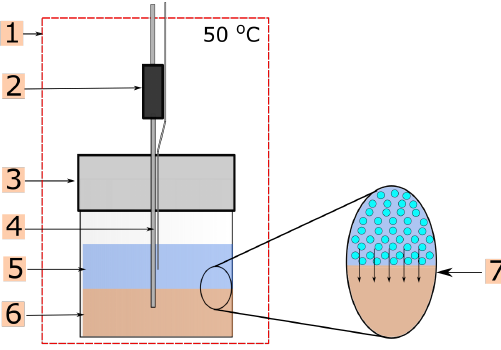
Figure 4. Graphical representation of the mass transfer happening during carbonated produced water injection and microcalorimeter description. 1—TAM IV microcalorimeter at 50 ◦ C, 2—titration ampule, 3—reaction vessel, 4—titration shaft, 5—carbonated produced water, 6—crude oil and 7—CO 2